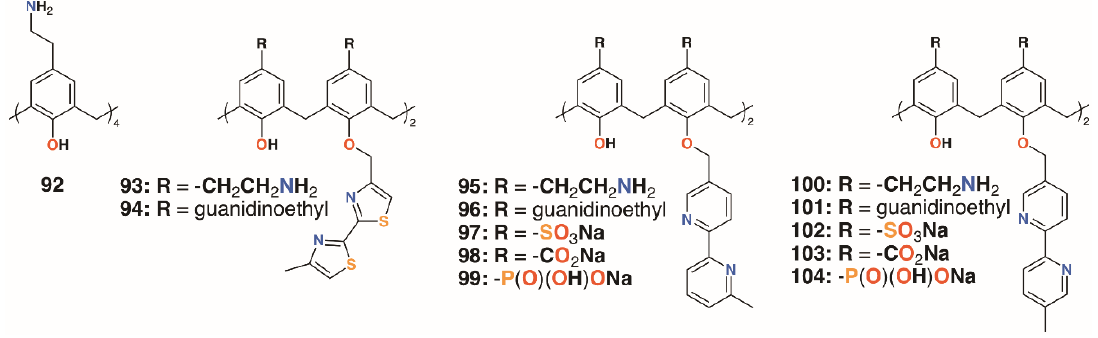
Figure 15. Regnouf-de-Vains’ charged calixarenes.